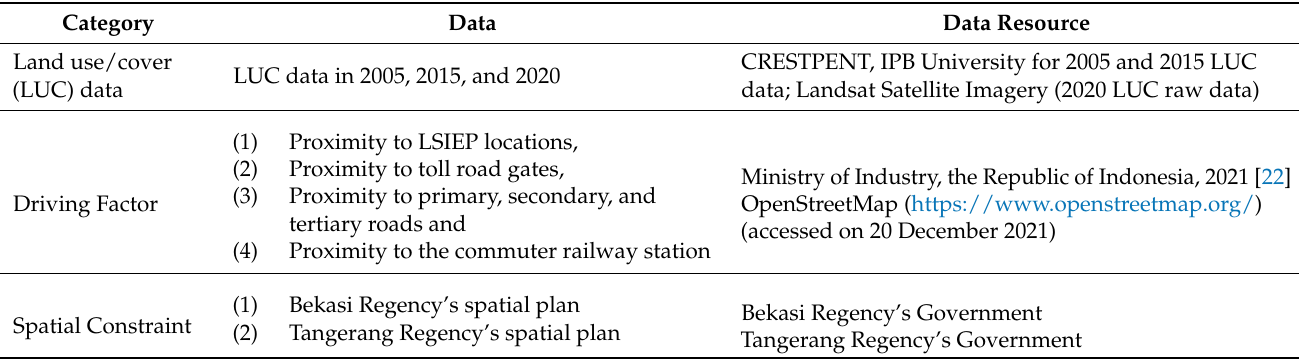
Table 1. A list of data used in this